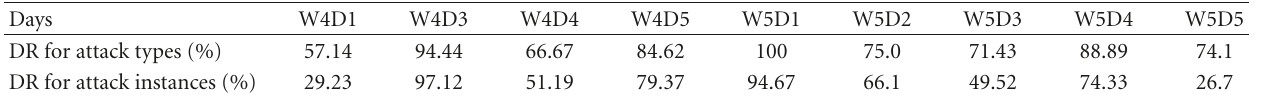
Table 3: Detection rate for each